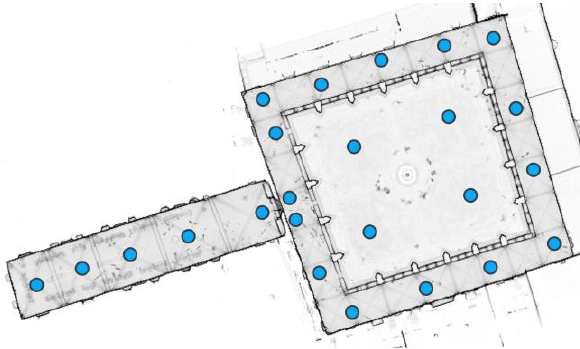
Figure 7. Case Study 1: Visualization of scan locations (blue circles) after registration. Similar results were obtained when using the three registration